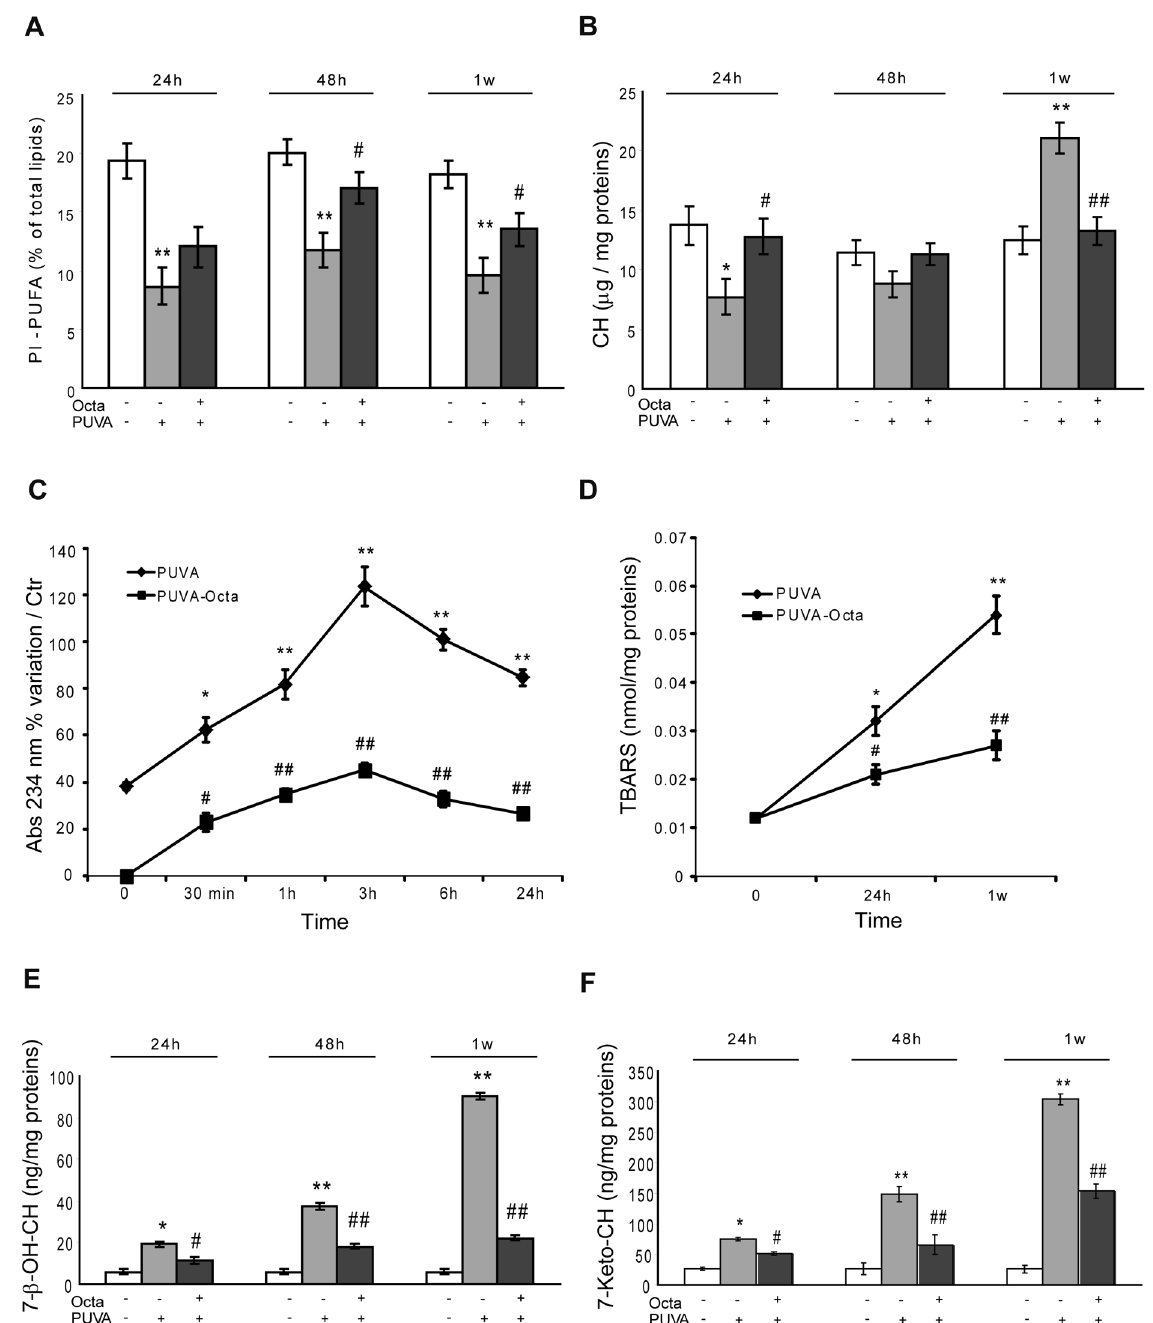
Figure 8. Octa counteracts alteration of lipid cell membrane homeostasis in PUVA treated HDFs. (A) Polyunsaturated fatty acids of membrane phospholipids (Pl-PUFA) in PUVA-treated HDFs were assessed GC-MS as described in Materials and Methods . (B) Chol content was analyzed by GC-MS as described in Materials and Methods . (C) Early lipid peroxidation products were assessed by the spectrophotometric evaluation of conjugated diene levels as described in Materials and Methods . (D) End products of lipid peroxidation were measured according to TBA assay as described in Materials and Methods . (E) and (F) Chol oxidation was evaluated by assessing 7 b -OH-CH and 7-keto-CH as described in Materials and Methods . *p , 0.05; **p , 0.001 respect to control fibroblasts; # p , 0.05; ## p , 0.001 compared with PUVA-treated fibroblasts. doi:10.1371/journal.pone.0104045.g008 Since PPAR c is a key player in lipid metabolism and because membrane phospholipids play a causal role in the aging process damage to cellular lipids is involved in the imbalance of the by modulating oxidative stress and molecular integrity [68,69]. 8- antioxidant network, we investigated the consequences of PUVA MOP can permeate cell membranes and establish photochemical cross-links between its furan or pyrone ring and unsaturated lipid treatment for lipid composition and the possible interference of Octa against this damage. Among the cell compartments, molecules [70], and the subsequent UVA exposure disturbs the